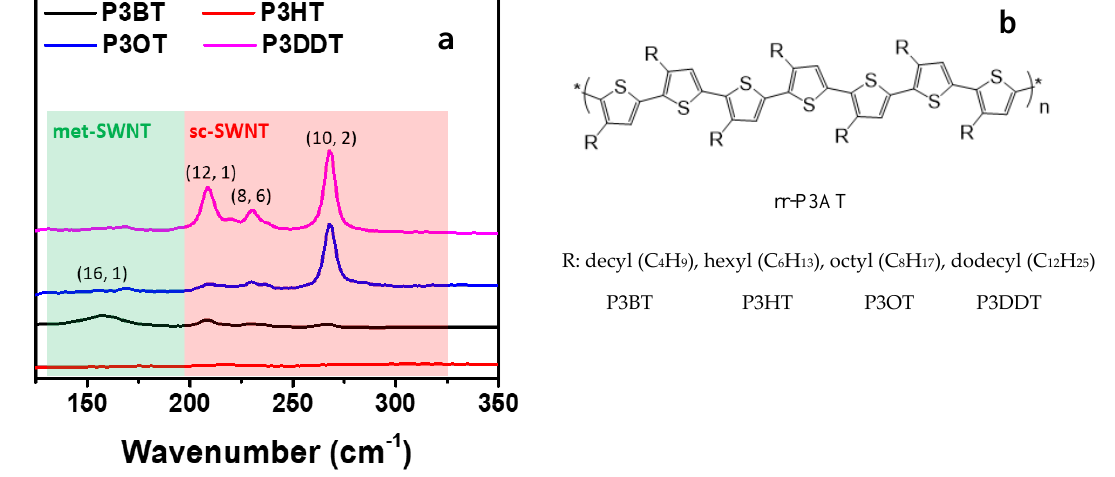
Figure 2. ( a ) RBM regions of resonant Raman scattering spectra at 1.58 eV (785 nm) excitation energies of the supernatants containing sc-SWNTs with various rr-P3ATs as dispersant; ( b ) Chemical structures of the various polythiophenes investigated.